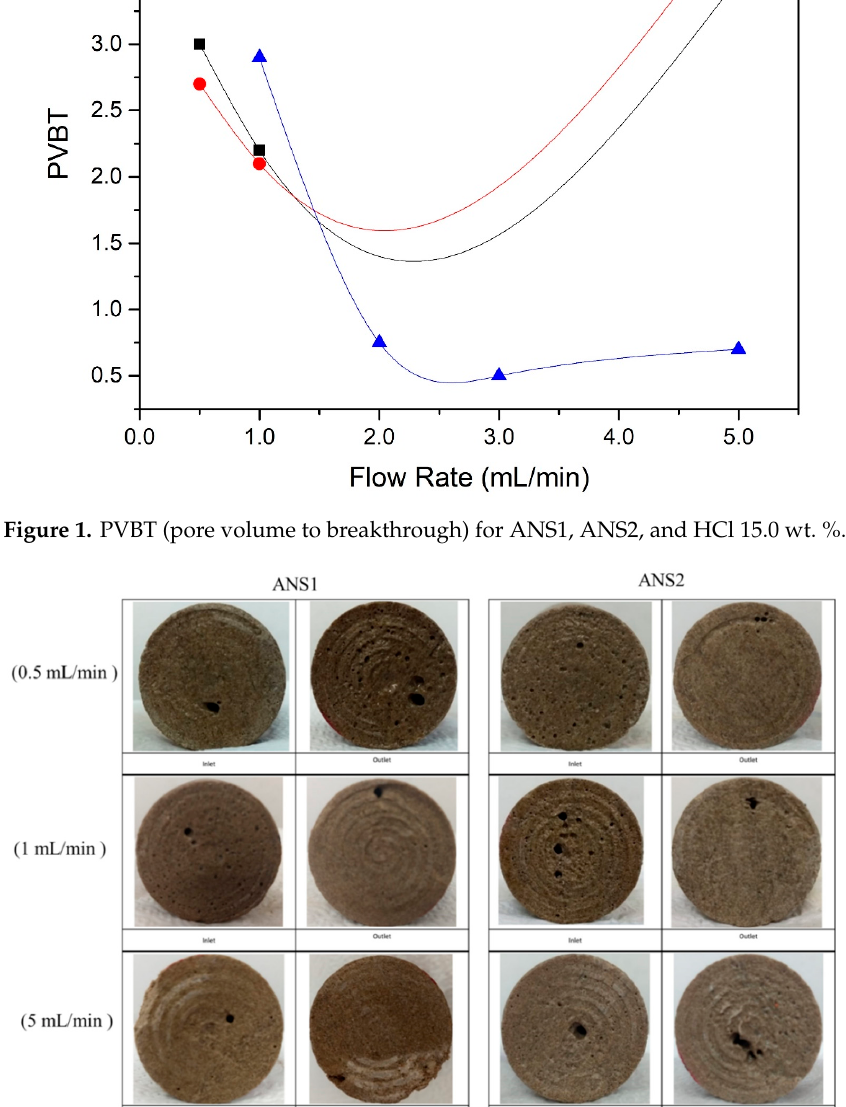
Figure 2. Inlet and outlet core plugs for the systems ANS1 and ANS2 at different flow rates.